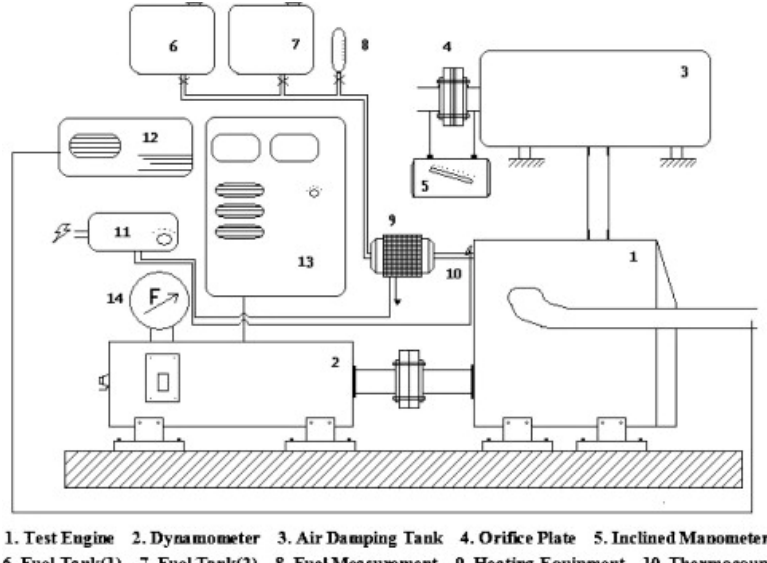
Figure 3. Schematic diagram of diesel engine set ‐ up.